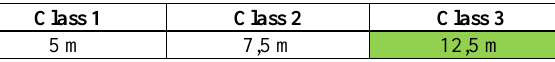
Table 2. Vertical accuracy in scale